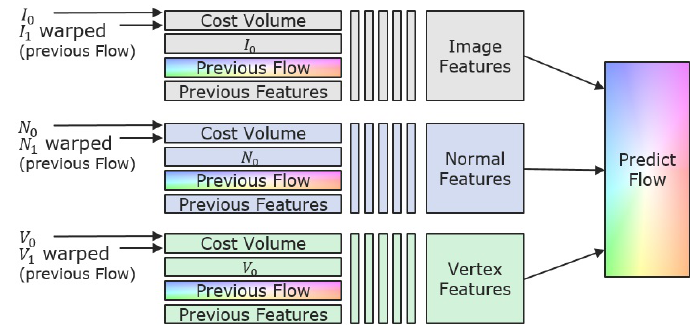
Figure 5. Possible input that is available to the task of light resistant optical flow estimation and subsequent pose prediction. In addition to texture images, there are depth maps, vertex maps, point clouds and normal maps available. The depth maps as well as the vertex maps contain geometrical information. Since the vertex maps are independent of the calibration, it is the preferable choice for the presented method.